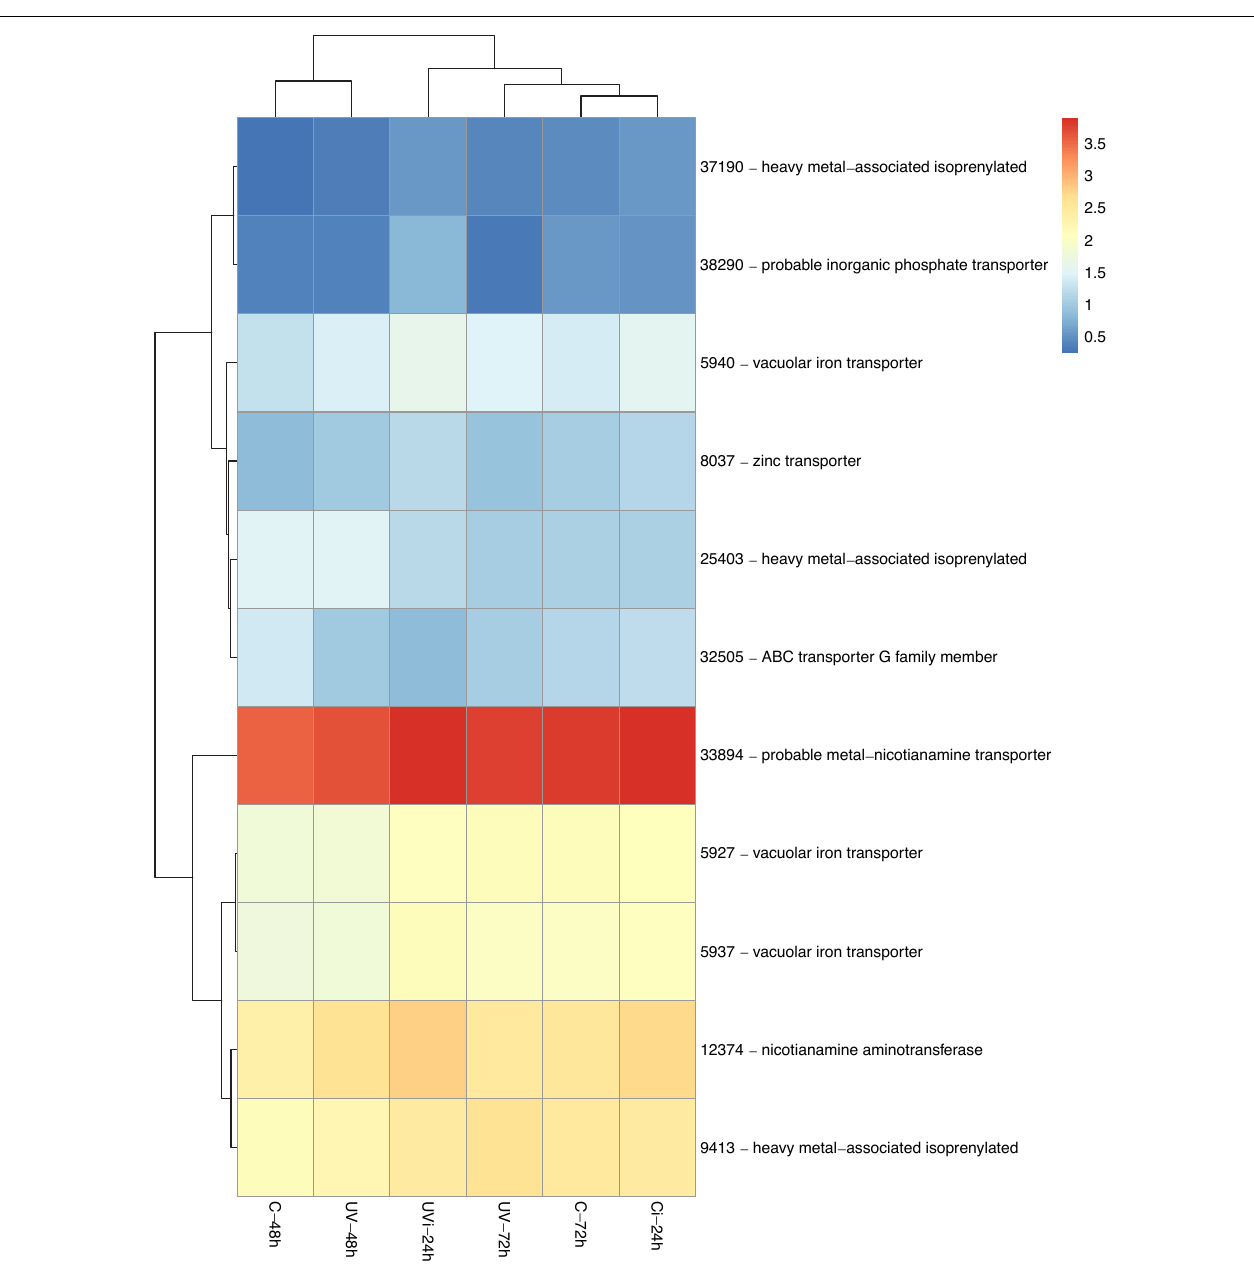
FIGURE 2 | Genes related to metal transport differentially expressed in response to UV and Xcv inoculation. Test of hierarchical DEG (HCA) groupings. The colors reflect the level of relative gene expression. The columns and rows represent the samples and ID_genes associated with the name/function of the corresponding proteins that were grouped according to their relative expression profile, respectively. C-48 h, control corresponding to treated 48 h after UV; UV-48 h, UV after 48 h treatment; C-72 h, control corresponding to treated 72 h after UV; UV-72 h, UV after 72 h treatment; Ci-24 h, control 24 h after inoculation; UVi-24h, UV 24 h after inoculation. The genes were filtered out with a threshold |log2-FC| > 1.5 and FDR <